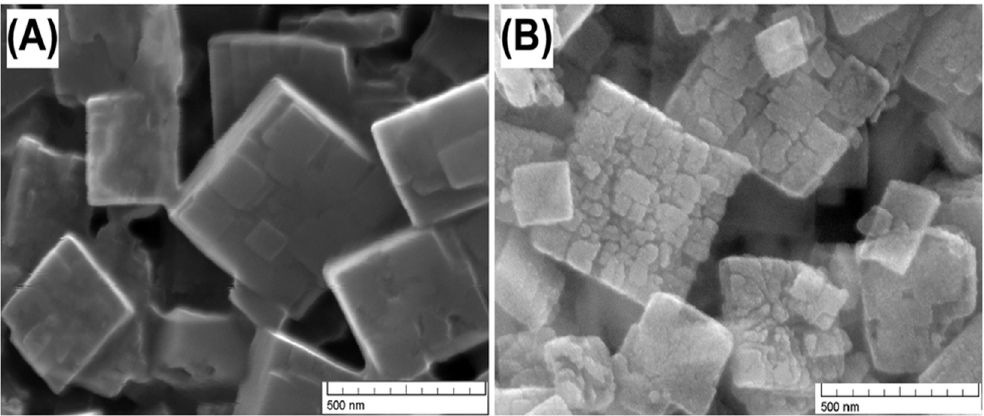
Figure 5. SEM images of ( A ) parent SAPO-34 and ( B ) fluoride treated hierarchical SAPO-34. (Adapted from [43]. Copyright 2016 Royal Society of Chemistry).